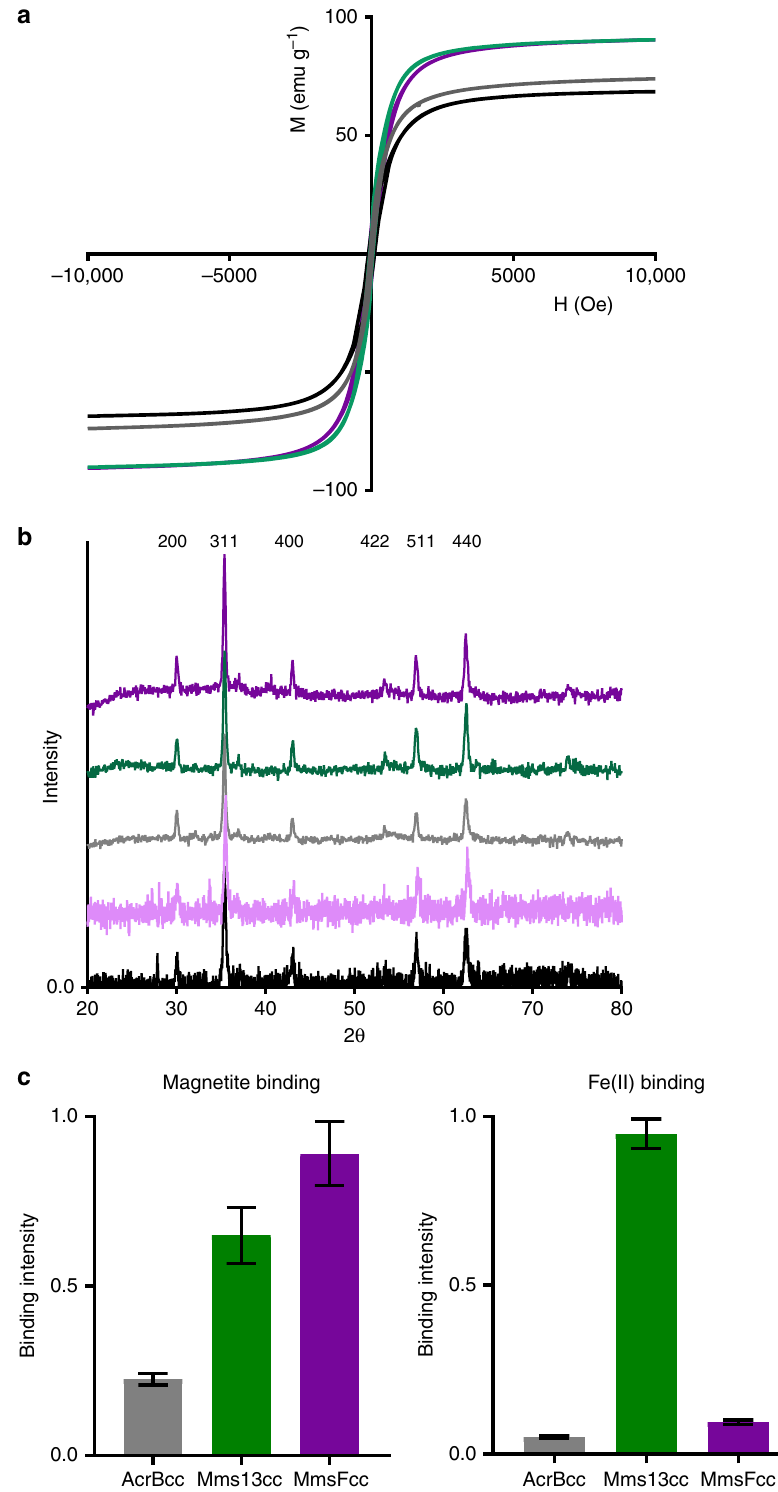
Fig. 4 Particle analysis and protein activity. a Vibrating sample magnetometry (VSM) analysis of particle samples generated with the three coiled coil proteins, MmsF peptide, and a protein free control. Magnetisation ( M ) in emu g − 1 and magnetic fi eld strength ( H ) in Oersted are displayed. b Powder X-ray diffraction analysis of the same particle samples. Miller indices at the top of the XRD patterns are assigned to re fl ections corresponding to magnetite. The data sets are offset for clarity. c Magnetite nanoparticle and ferrous iron binding analysis. Data are normalised to the highest reading in each experiment. Data = mean with standard deviation ( n = 3). In all parts, MmsFcc is depicted in purple, Mms13cc in green, AcrBcc in grey, protein free in black, and MmsF peptide in light